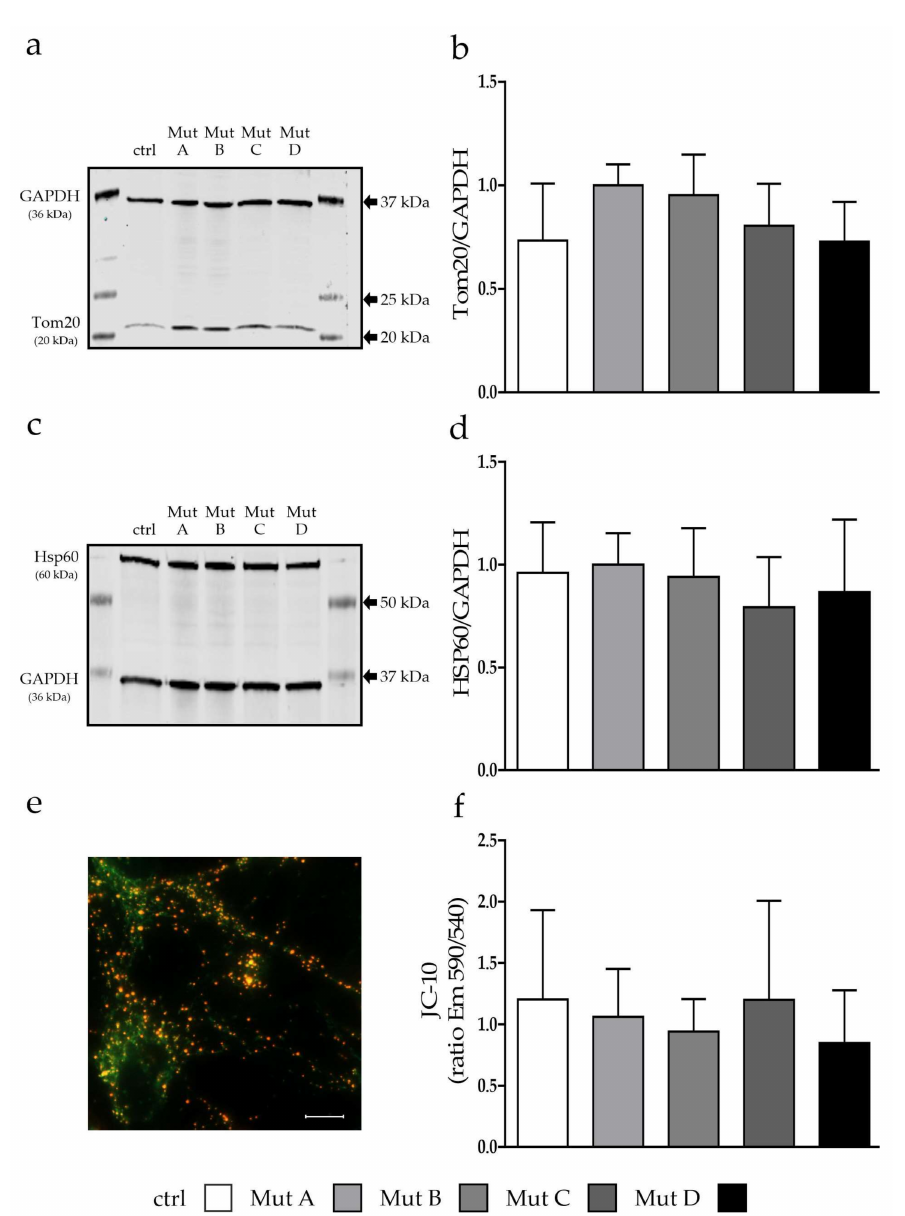
Figure 2. Evaluation of mitochondrial health. ( a ) Example of a Western blot for the mitochondrial marker Tom20 (20 kDa). ( b) Quantification of the Tom20 protein expression showed no differences, whereas two NPC1-deficient cell lines showed a slight increase. ( c ) Example of Western blot of the mitochondrial heat-shock protein Hsp60 (60 kDa). ( d ) Quantification of Hsp60 revealed no differences between the NPC-deficient and the control cell lines. ( e ) Example of living cells stained with the MMP marker JC-10. Scalebar = 10 µ m. ( f ) MMP was not affected in NPC-deficient cells. Graphs show mean ± SD with N = 4, n = 6–11 for ( b ) and ( d ), and N = 5 and n = 20 for ( f ). ctrl = control cell line. Mut A (NP-C1): c.1180T>C; Mut B (NP-C1): c.1836A>C/c.1628delC; Mut C (NP-C1): c.3182T>C; Mut D (NP-C2):